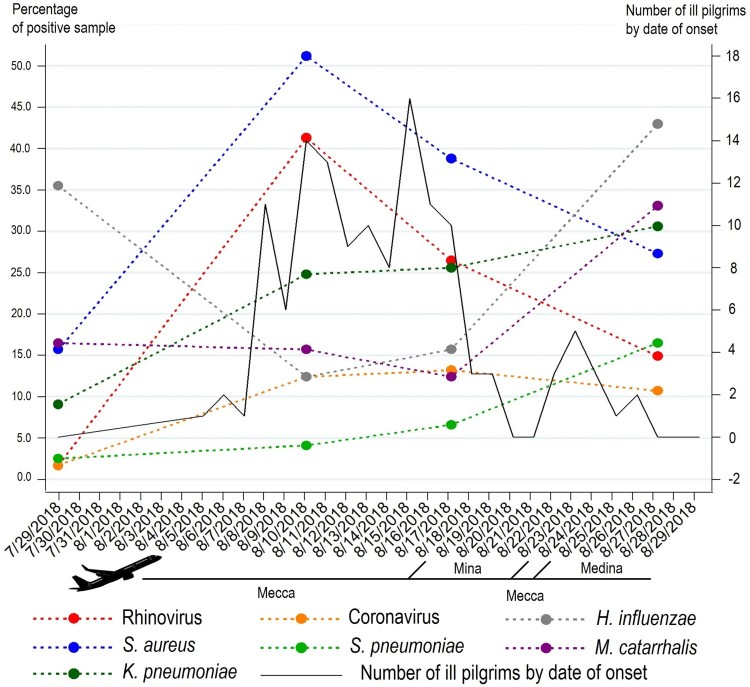
Dynamics of respiratory pathogen carriage during the 2018 Hajj and onset of respiratory symptoms among pilgrims.